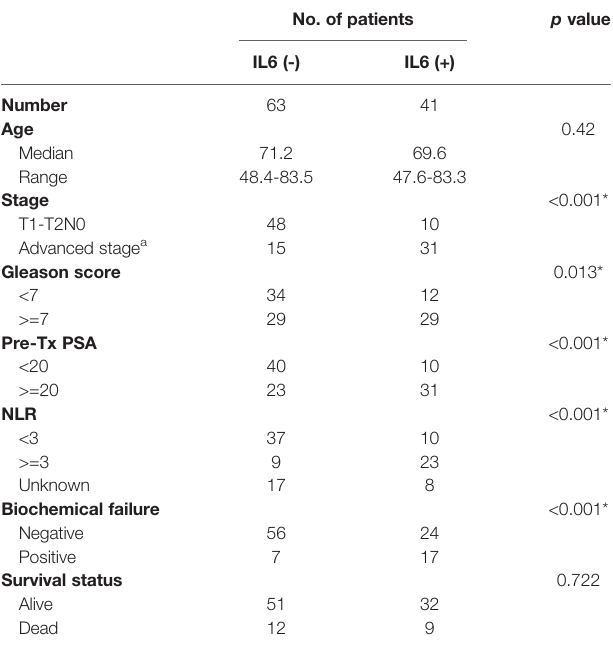
TABLE 1 | Clinical characteristics of